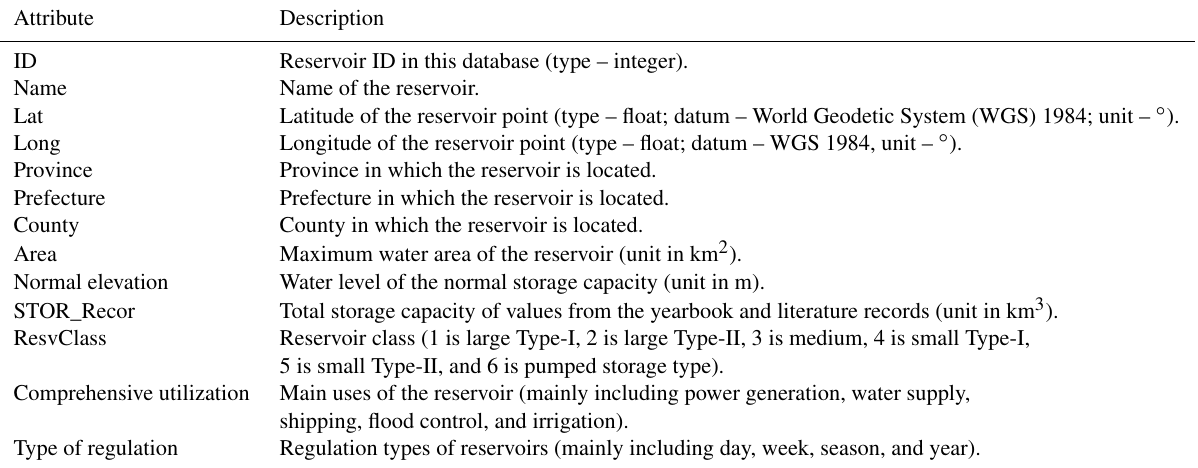
Table 1. Attributes in the recorded (5143) reservoirs from the yearbook and document data.